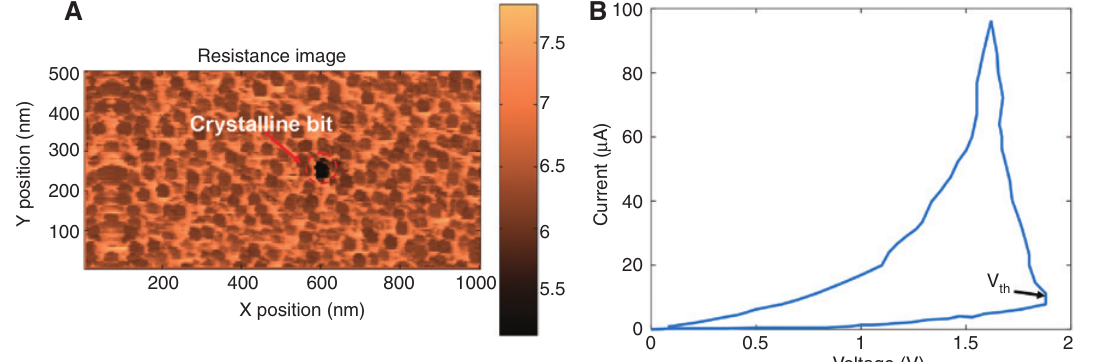
Figure 2: (A) The crystalline bit obtained from PCPM with TiN bottom electrode using a 2 V pulse of 100 nss duration and (B) the resulting I–V